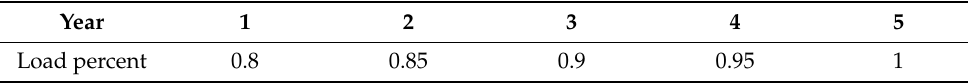
Table 4. Load percentage in different